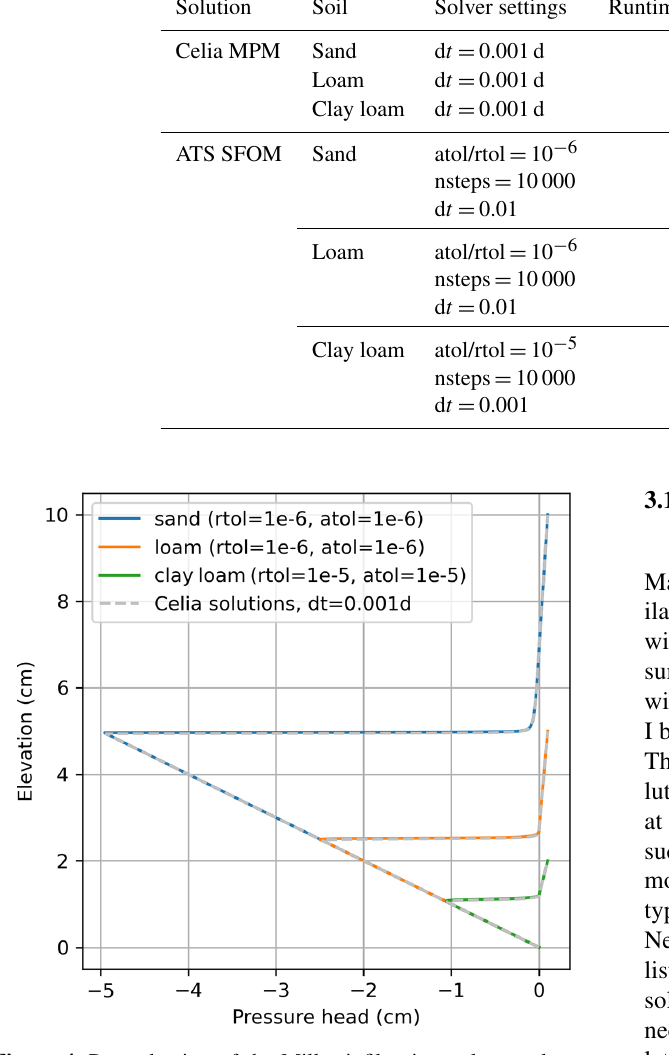
Figure 4. Reproduction of the Miller infiltration pulse result, us- ing Celia’s MPM model and our ATS SFOM solution. Both models are satisfactorily consistent with the output reported by Miller et al. (1998), in their Fig.